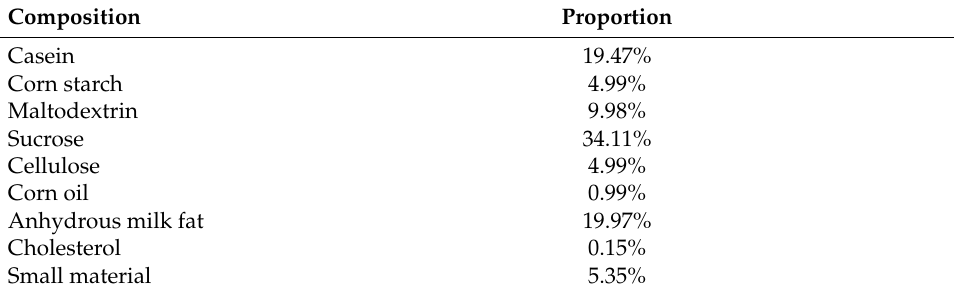
Table 6. The composition of the high-fat diet